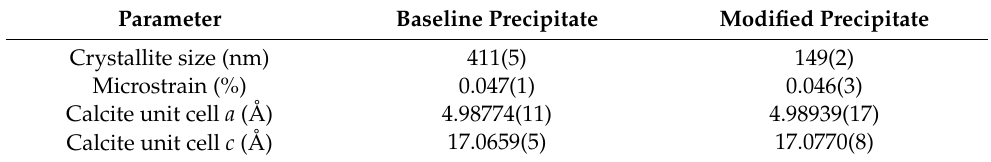
Table 1. Results of Rietveld refinement.